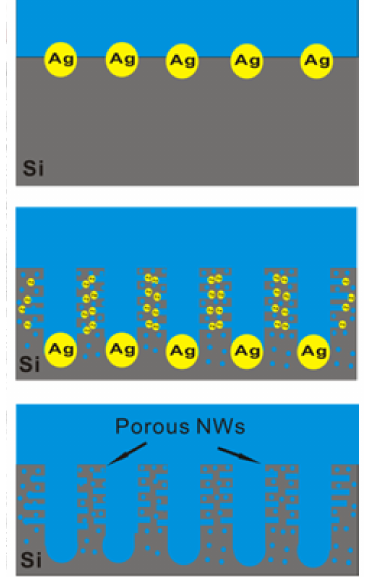
Figure 1. Schematic diagram illustrating the etching procedure of 1D–PSiNWs on silicon